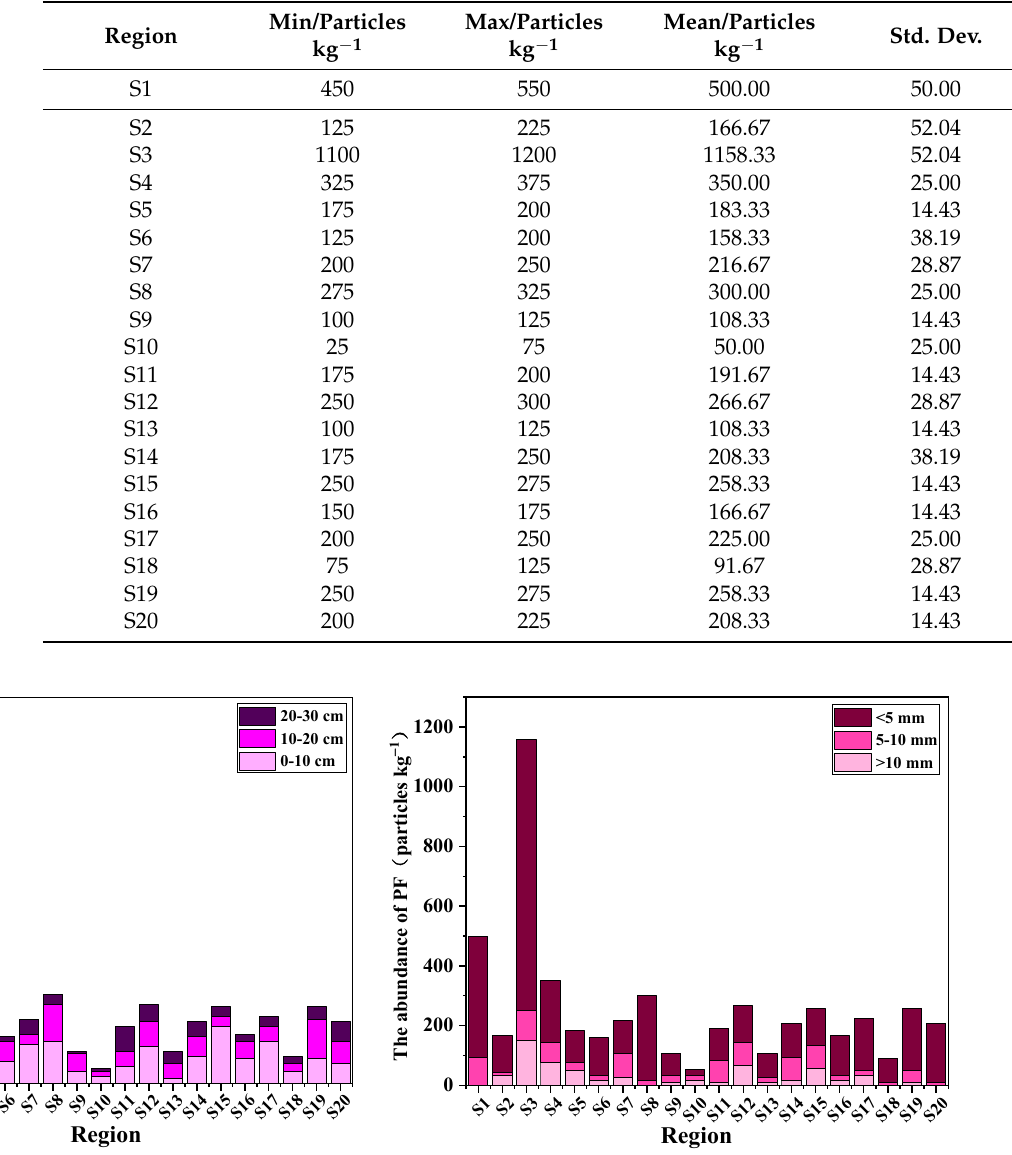
Table 1. The abundance of PF at sampling sites.